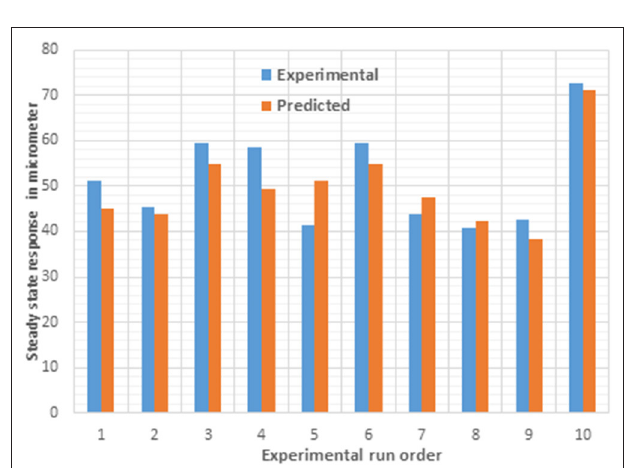
FIGURE 7 | Comparison of experimental and predicted values of steady-state response (Mean +